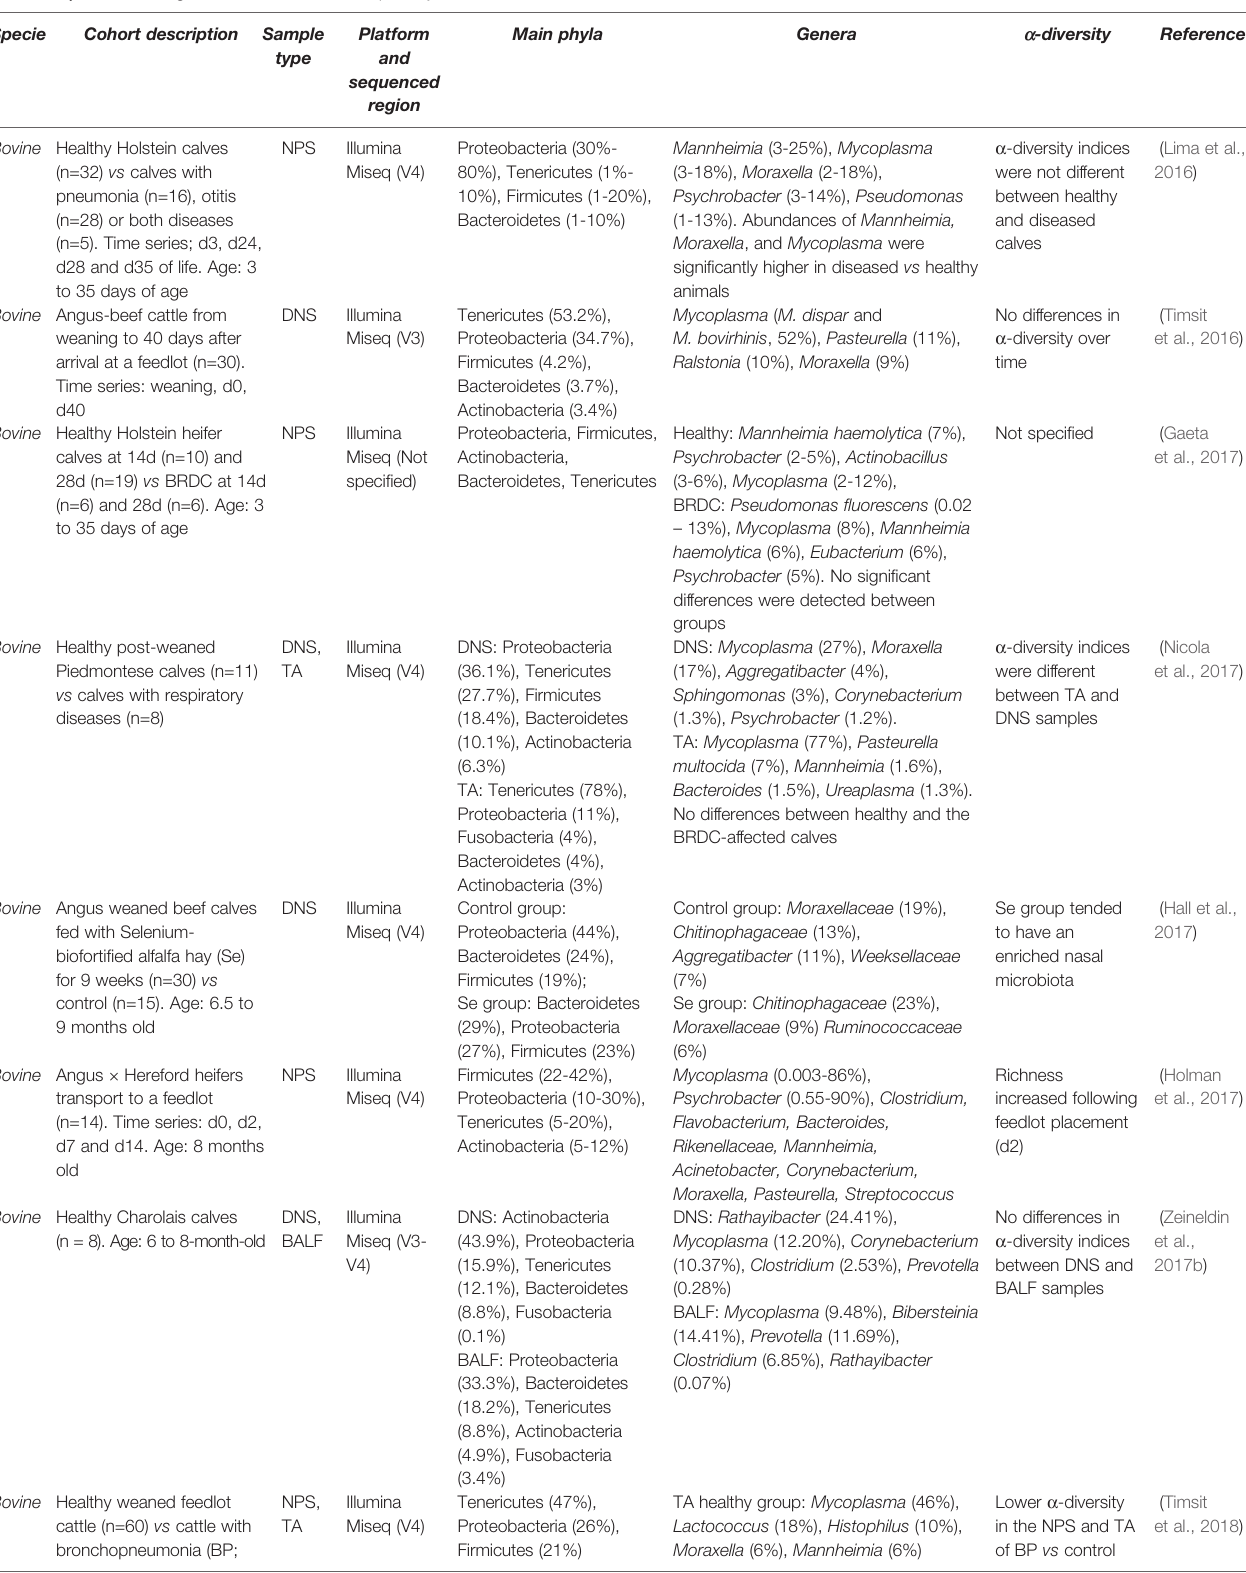
TABLE 1 | Recent metagenomic studies on the respiratory microbiota of domestic animals.